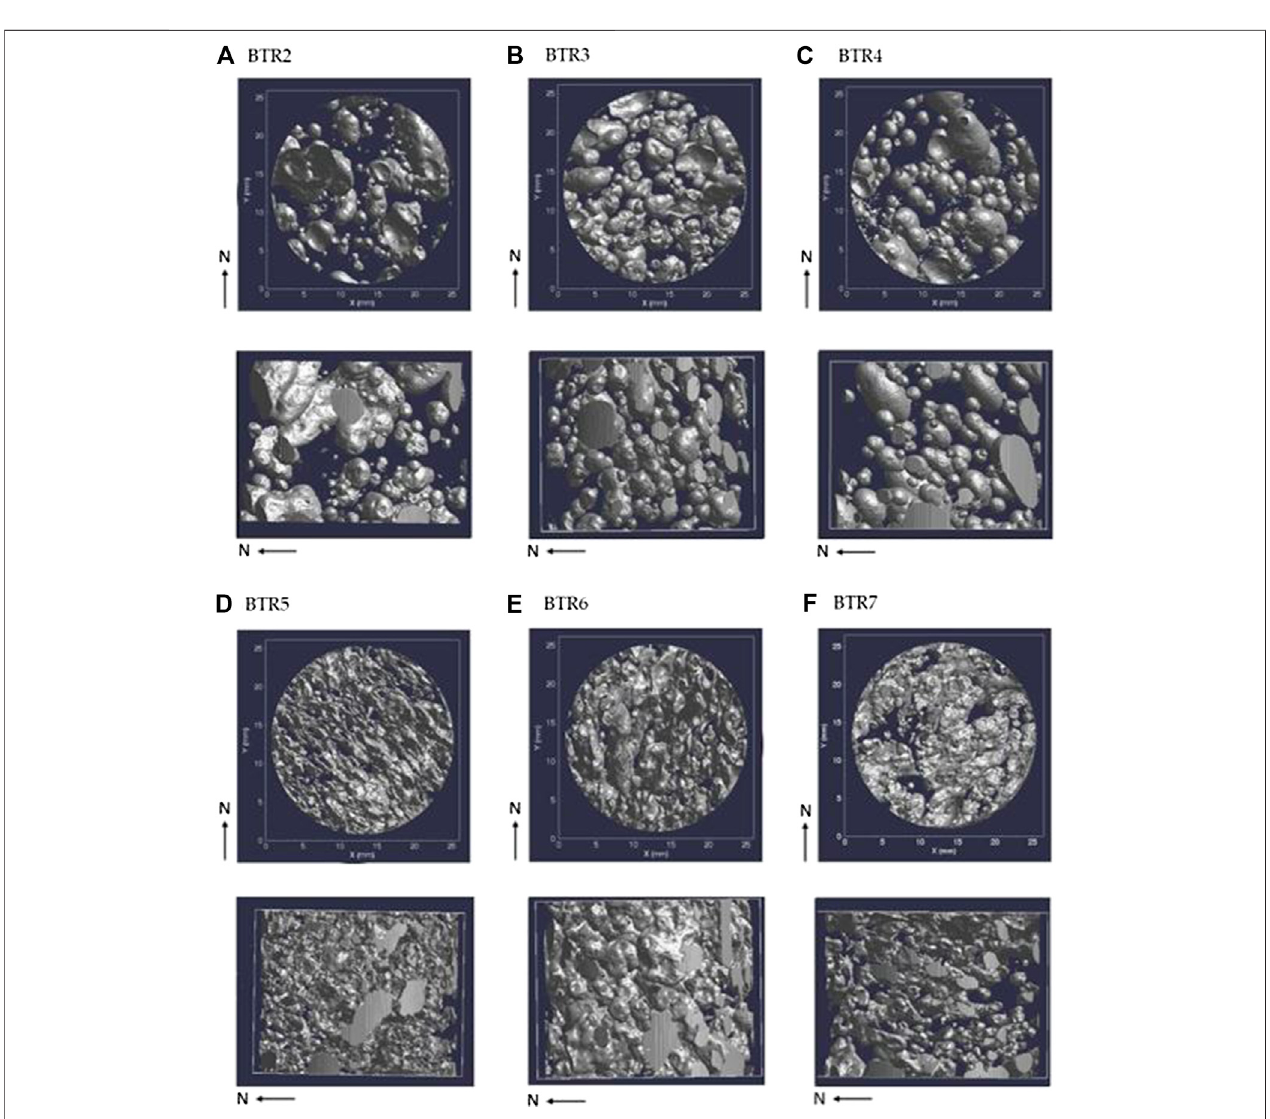
FIGURE5| Poredistributionimagesof (A) BTR2; (B) BTR3; (C) BTR4; (D) BTR5and (E) BTR6;and (F) BTR7seenfromthetop(circles)andtheside(rectangles)of the core specimens. Gray area represents the pores. Round images are the vertical view of each sample while rectangular images represent the side view. N indicates north directions. Vertical streaks are from where the pores intersect the scan fi eld.